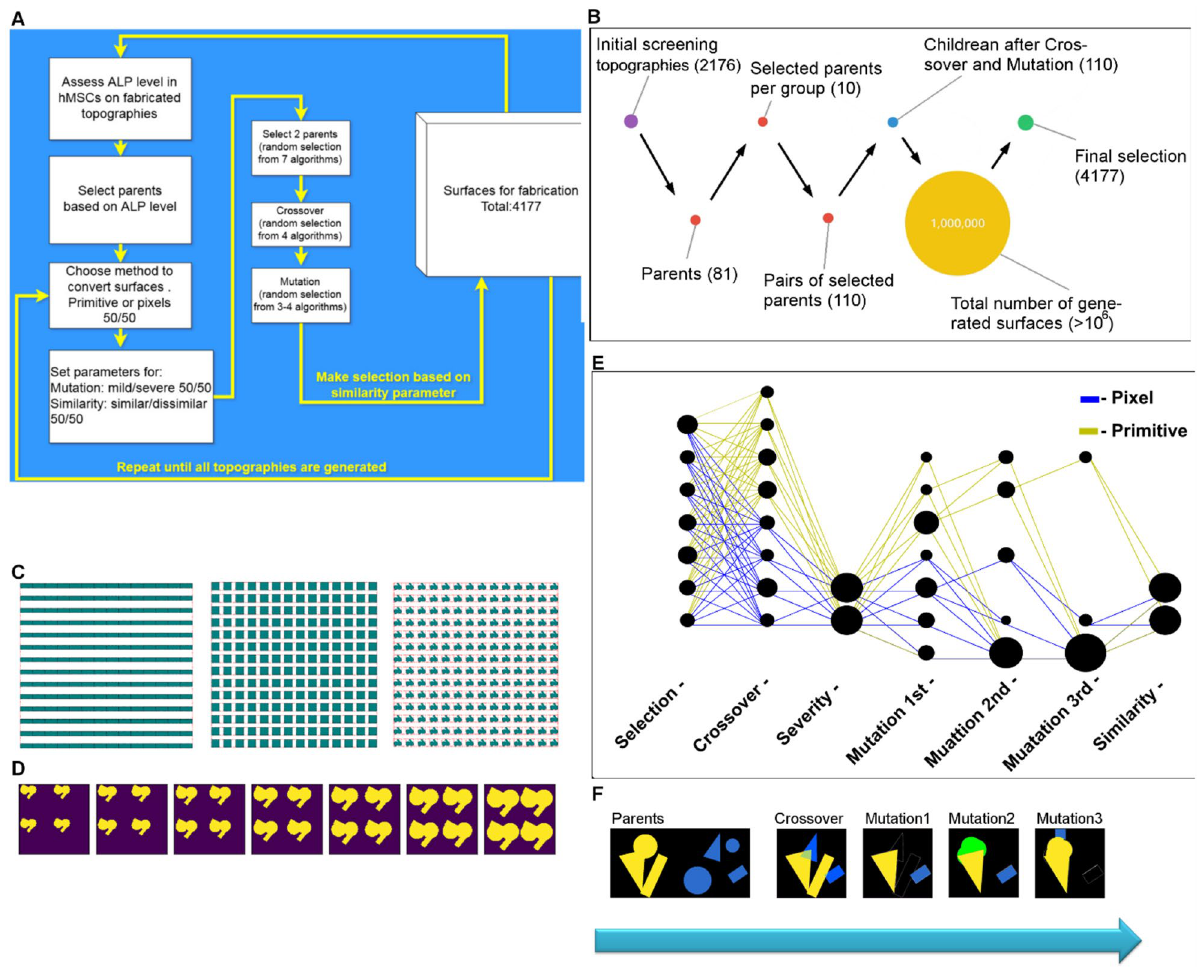
Figure 3. The flow of genetic perturbations. ( A ) Schematic representation of the genetic perturbation flow. ( B ) Schematic representation of surface numbers in every step of genetic perturbation. ( C ) Examples of control surfaces. ( D ) Different sizes of the ALP hit surface. ( E ) The flow of genetic perturbations with the second generation of the GTopoChip1. Every bubble corresponds to a single function or parameter that belongs to step specified on X-axis. The size of the bubble represents the number of surfaces that were generated with that particular function or parameter. ( F ) Example of surface generation: after parental crossover one child has 3 consecutive mutation steps. Yellow and blue colours correspond to the parents, green colour represents inserted elements of the design, and white outline represents removed elements of the